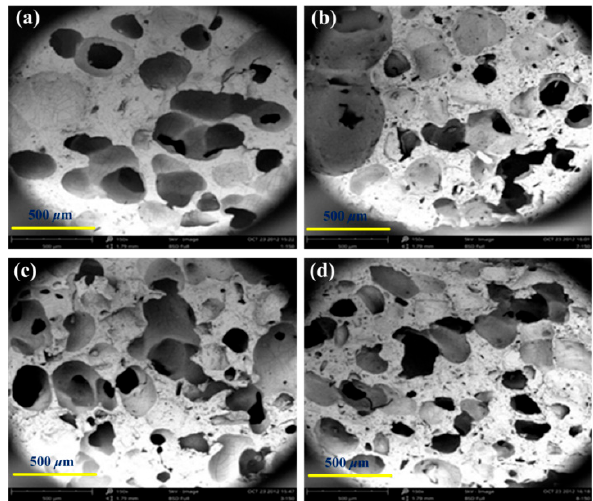
Figure 1. SEM photographs of silicone rubber foam fabricated with different additive amounts of NaCl. ( a ) 20 phr; ( b ) 40 phr; ( c ) 60 phr; and ( d ) 80 phr.